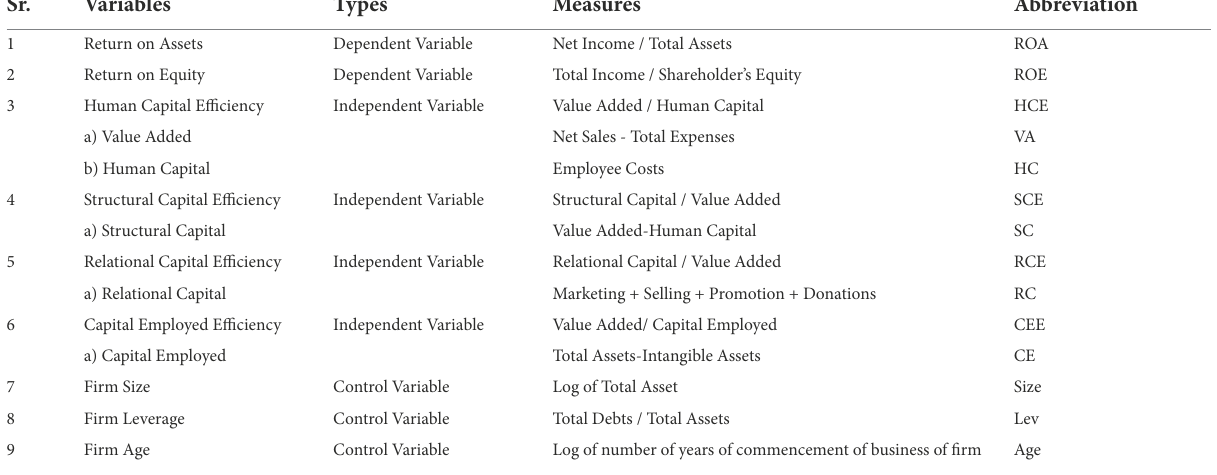
Table 1 Variables measurement and